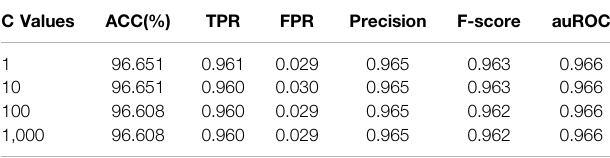
TABLE 4 | Performance comparison of hybrid features with different penalty parameter C values under linear kernel. C Values